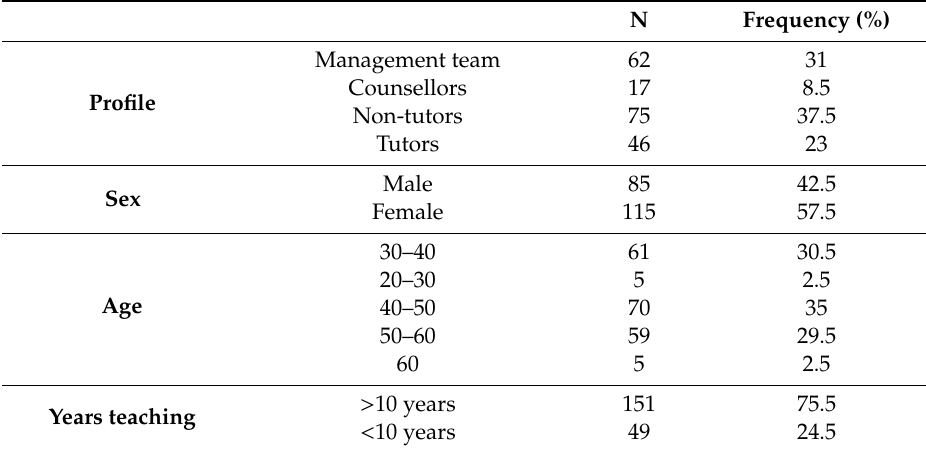
Table 2. Frequency of identifying characteristics of the